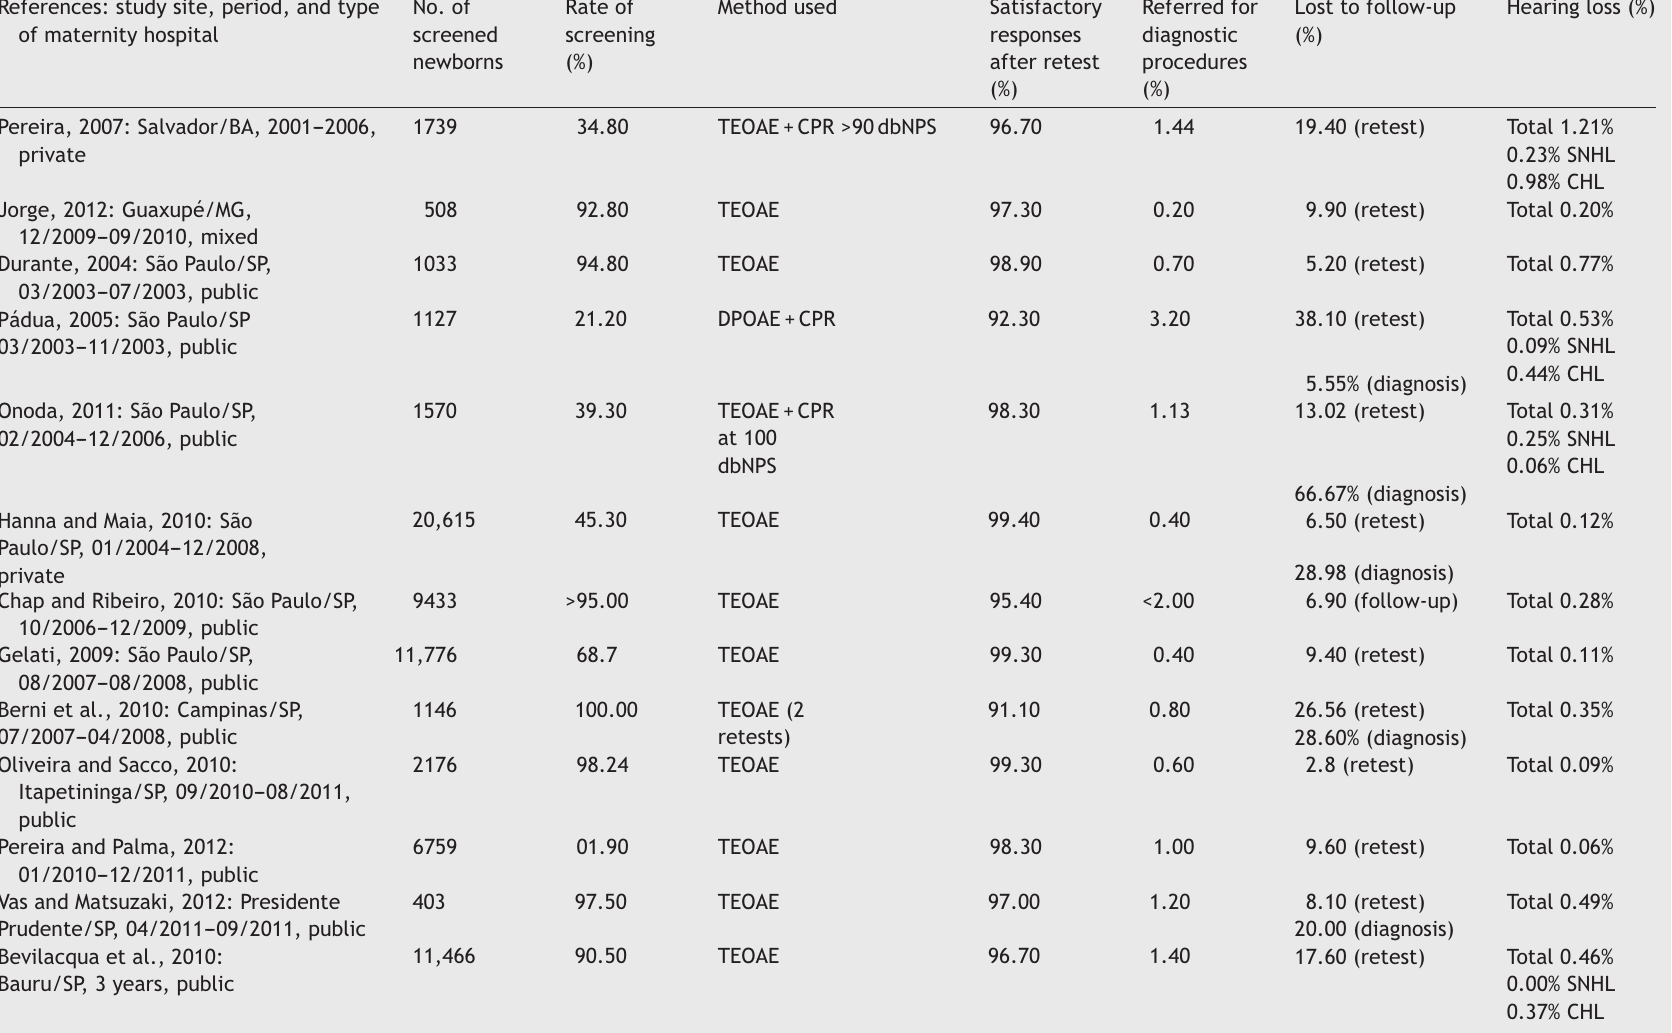
Description of the NHS in relation to the type of maternity hospital, city/town, time period, percentage of babies screened in relation to number of live births in the same period, result of NHS after the first phase, percentage of infants referred for diagnostic procedures in relation to the total screened infants, percentage of babies that left the program at some stage, and percentage of hearing loss in relation to the total number of screened